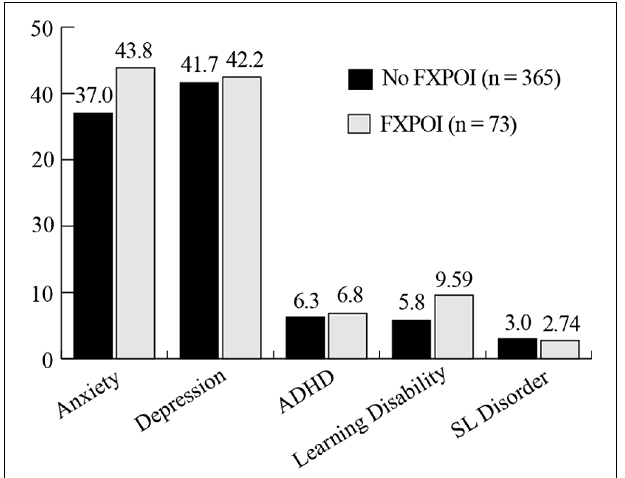
FIGURE 1 | Percentage of women with and without FXPOI endorsing co-occurring psychiatric or educational conditions.